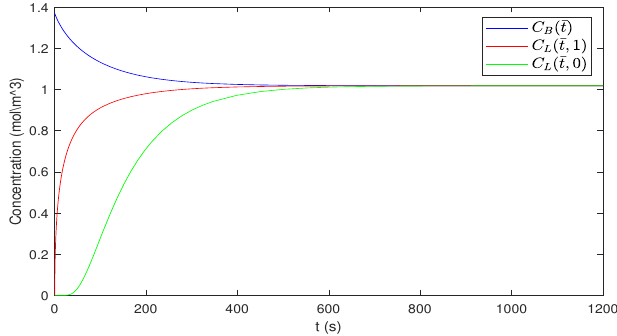
Figure 8. Dynamics of the concentrations obtained from the simplified model ( α = 4 . 14, β = 4) for the data reported in